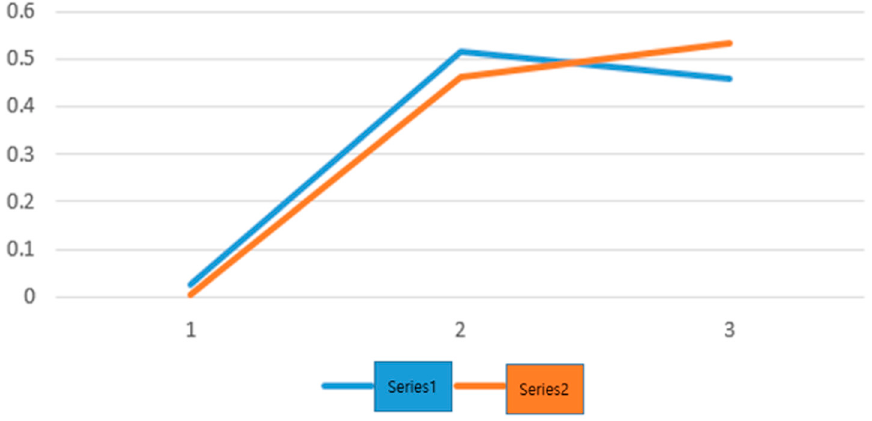
Figure 22. Comparison between the appearance frequency of “tropical night” and maximum power. (“Living Culture” section of Naver news, 2018).